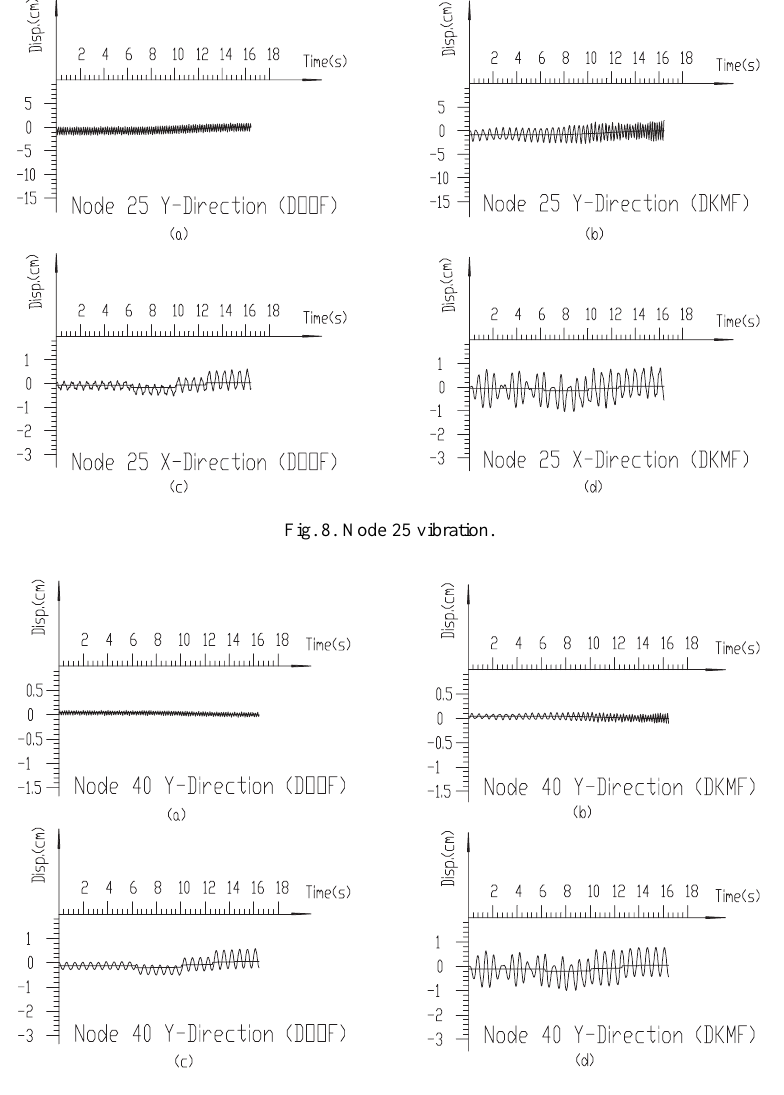
Fig. 8. Node 25 vibration.